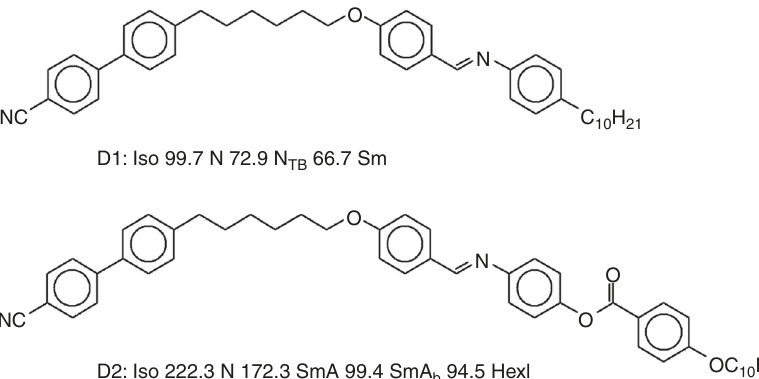
Fig. 1 Materials studied. Molecular structures and phase transition temperatures (in deg. C, detected by calorimetric studies on cooling scan) for the compounds D1 and